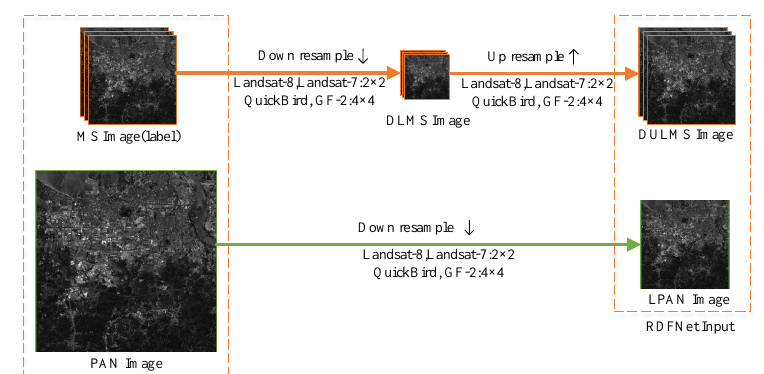
Figure 3. Workflow of generating training datasets according to Wald protocol.